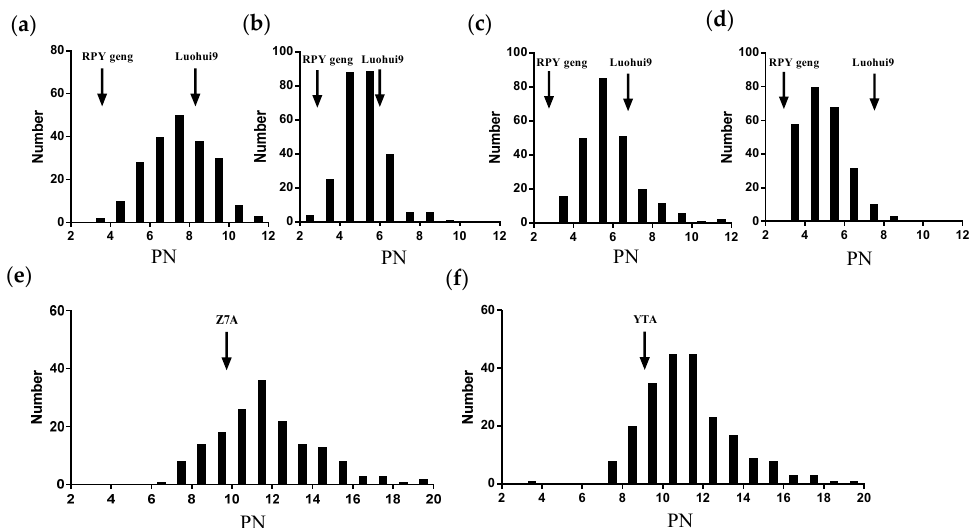
Figure 1. The distribution pattern of the PN trait in RILs and two testcross hybrid populations. ( a – d ) Column graphs of PN for RIL population in HB191 ( a ), HB181 ( b ), HB171 ( c ), and HN162 ( d ), respectively. ( e , f ) Column graph of PN for Z7A-TCF 1 population ( e ) and YTA-TCF 1 population ( f ) in HB191.